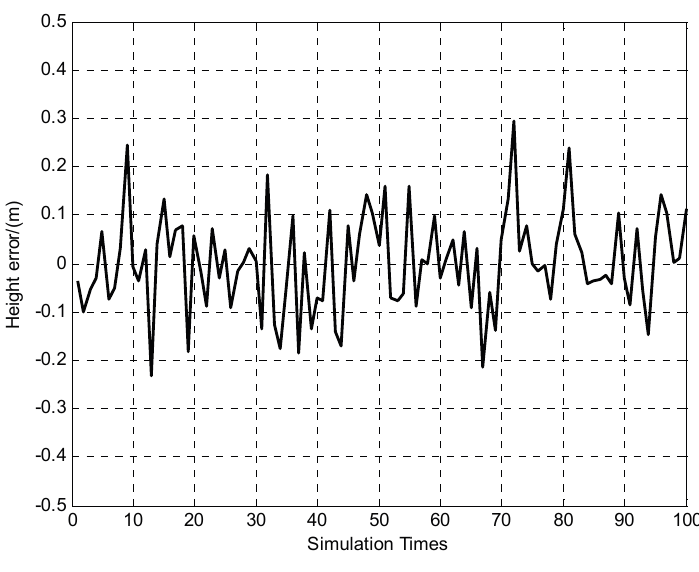
Figure 9. 100 times of height error determination results.